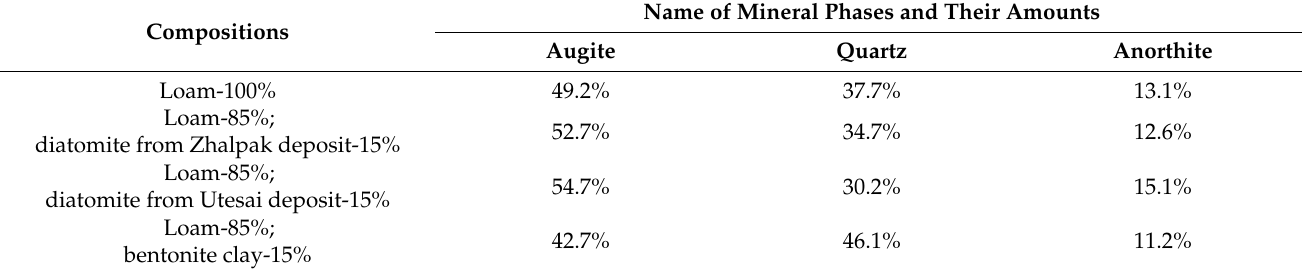
Table 6. The phase compositions of samples burned at 1170 °C.